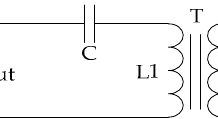
Figure 3. The arc generator: ( a ) structure; ( b ) the actual device. Sensors 2016 , 16 , 500